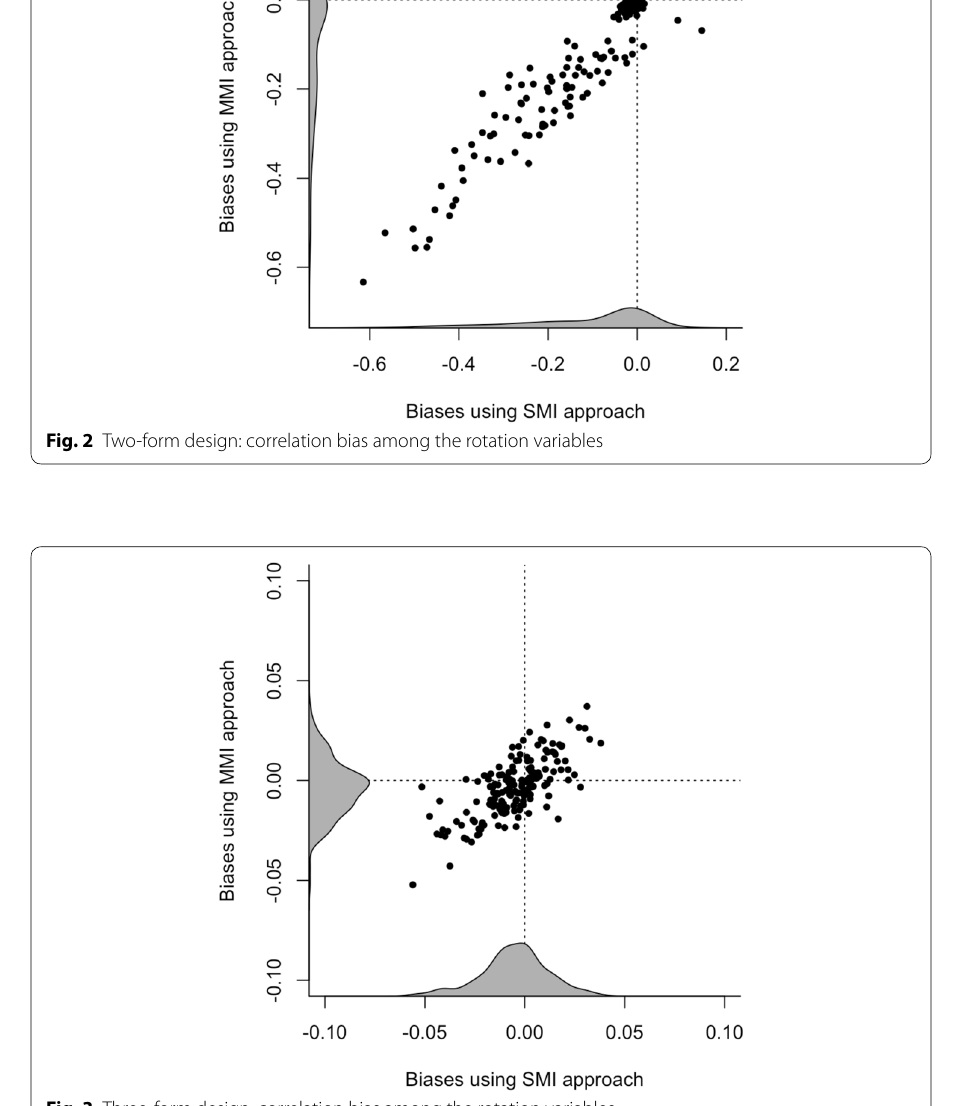
Fig. 3 Three-form design: correlation bias among the rotation